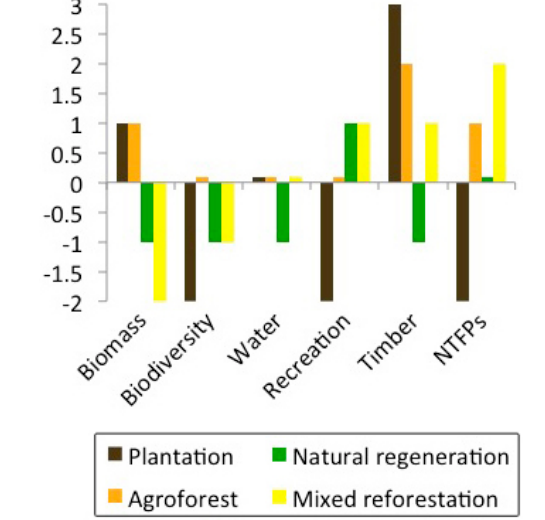
Fig. 3 . The services resulting from different forest-transition types based on case studies. Each service was compared to a primary forest baseline in the country in which the transition was occurring, and was given a score from -3 to 3 based on studies that quantified or described the services found in the secondary forests in each. A negative value indicates a reduction in a given ecosystem service after the forest-area inflection point relative to provision levels of primary forest; a positive value indicates an increase in a given ecosystem